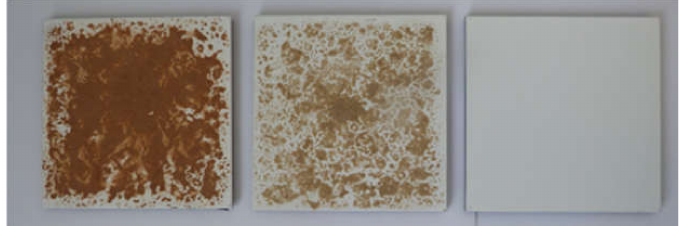
Figure 5. Picture of the set of samples after the sand deposition, with sand from Ouarzazate ( left ), with sand from Dubai ( center ), and without sand ( right